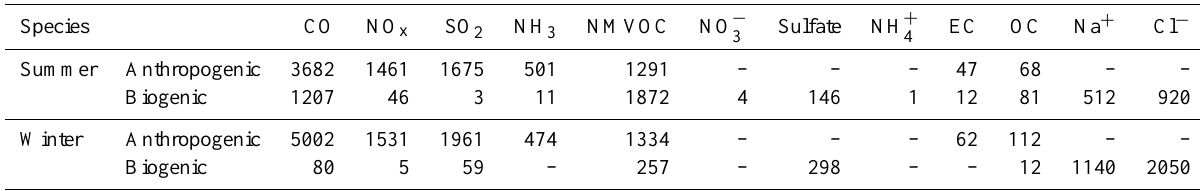
Table 1. Emission mass totals for gaseous and PM 2 . 5 species (in ktonsmonth − 1 ) for the European domain during the modelled summer and the modelled winter